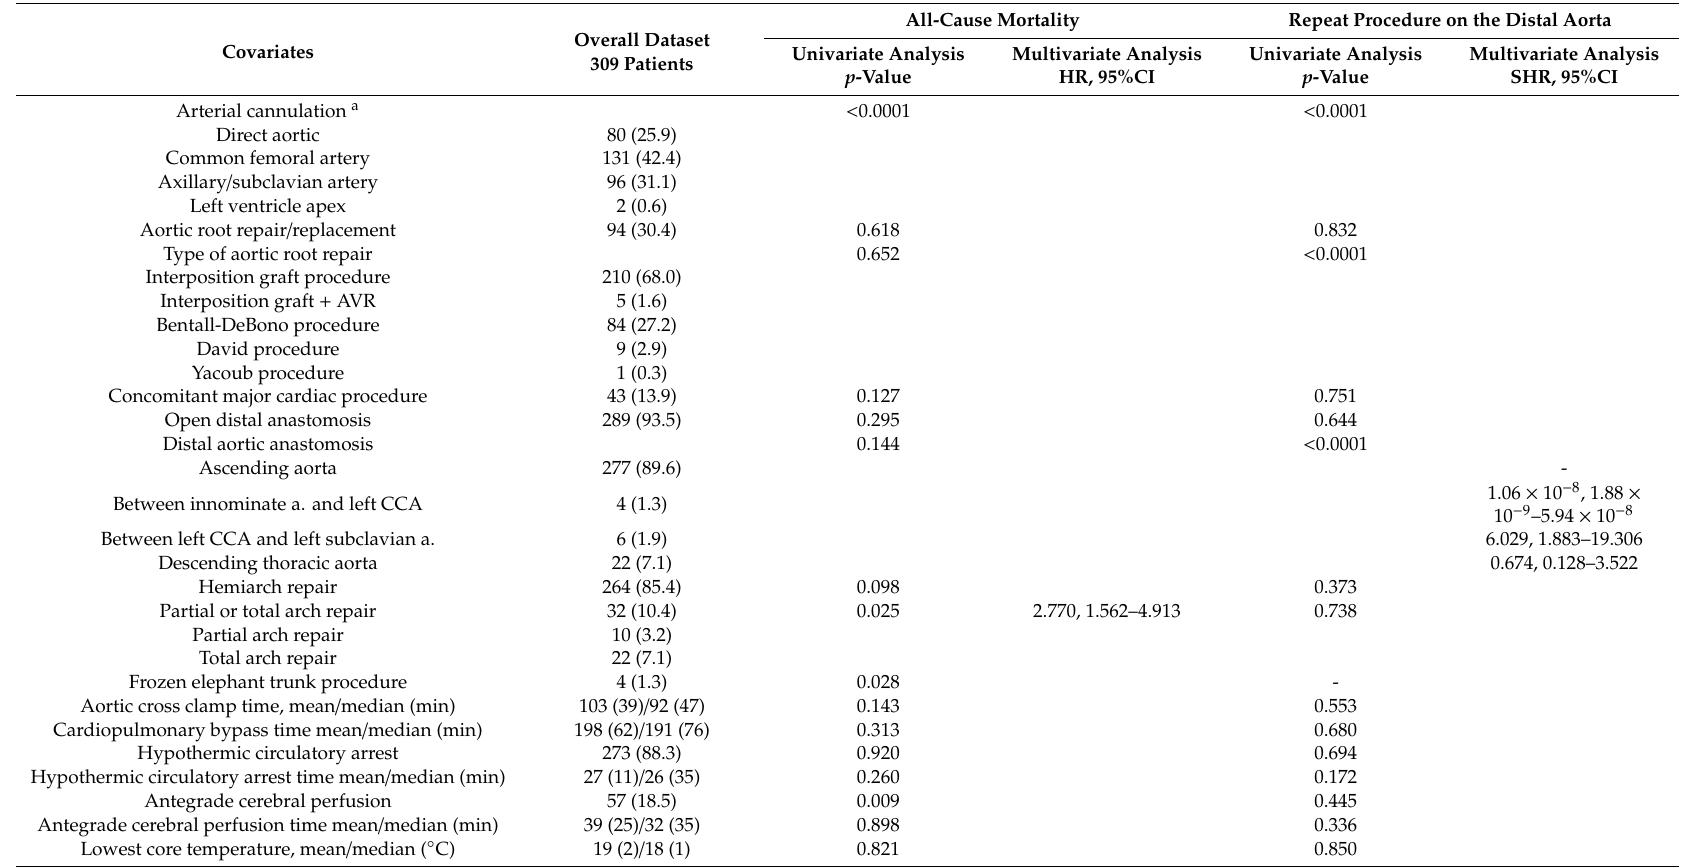
Table 2. Operative data and predictors of outcome in patients who underwent surgical repair for type-A aortic